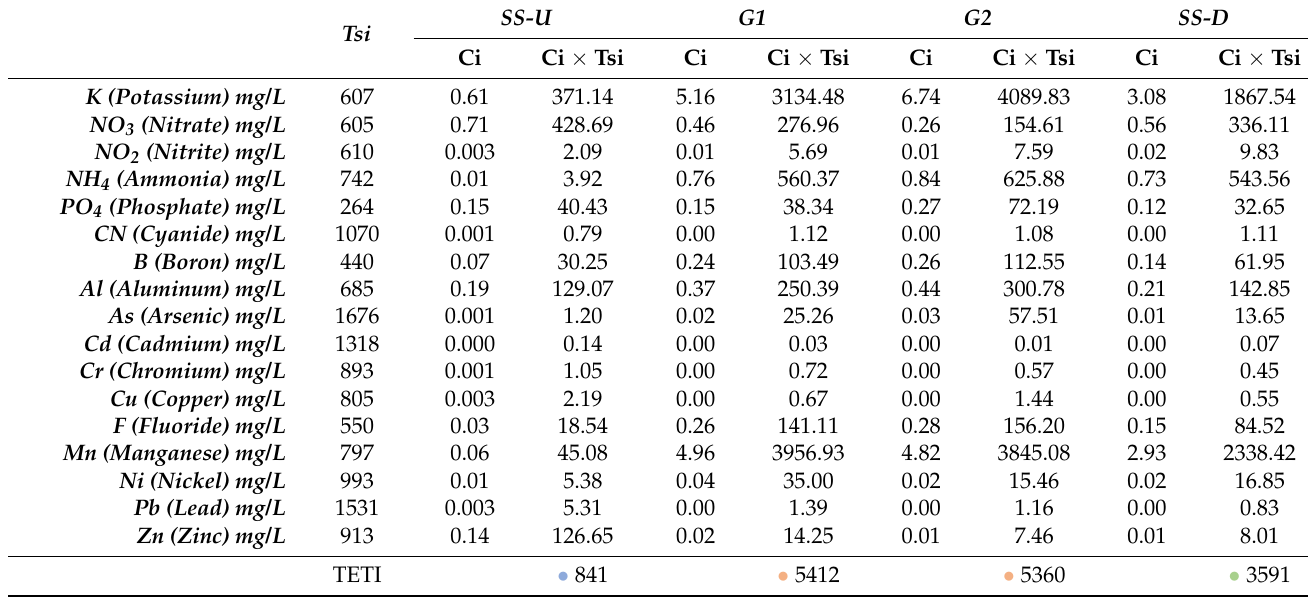
Table 5. Trace element toxicity index